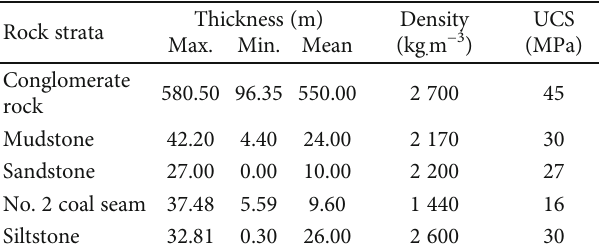
Mudstone Sandstone